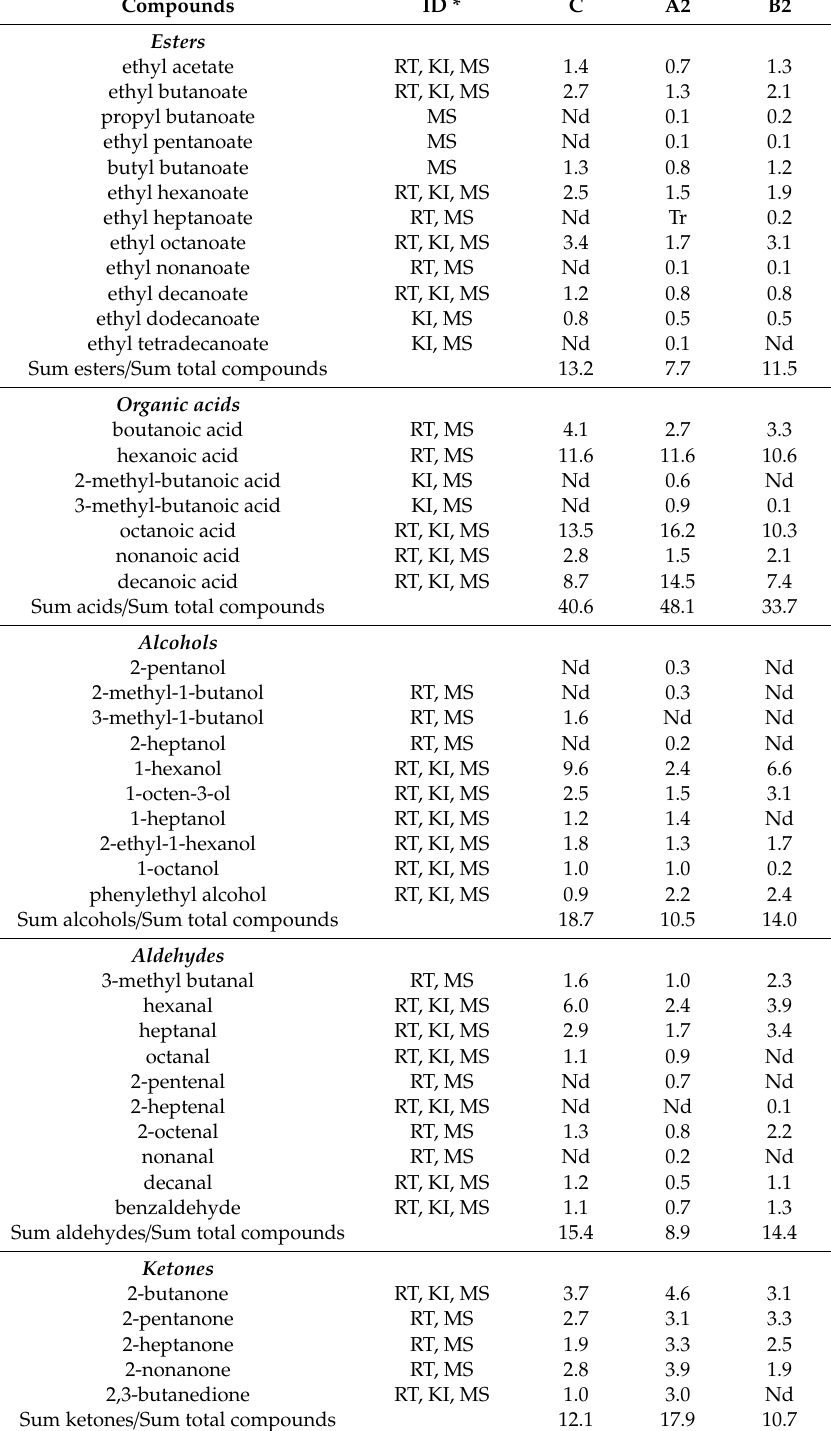
Table 2. Volatile compounds identified by solid-phase microextraction gas chromatography / mass spectrometry (SPME / GC-MS) in whey beverages (A2: 0.6 g of the immobilized biocatalyst per 100 mL of whey; B2: 0.6 g of Pistacia terebinthus resin per 100 mL of whey; C: control sample) after 30 days of storage (all values presented as